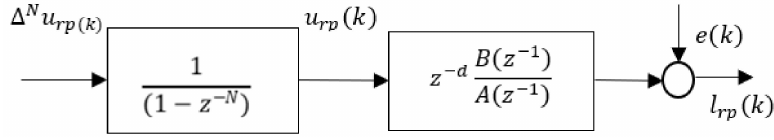
Figure 10. Repetitive N-periodic internal model in series with the